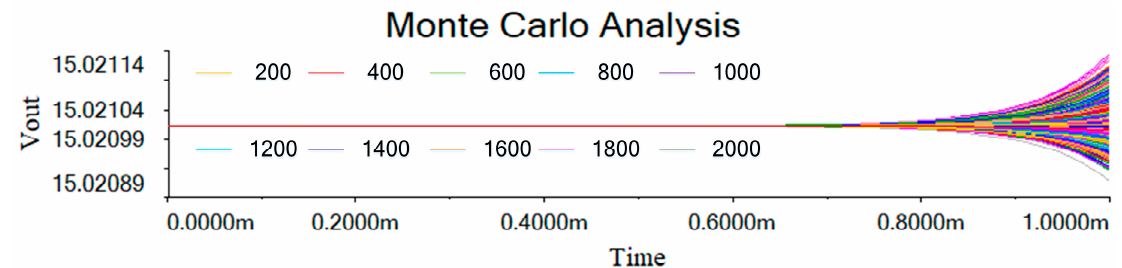
Figure 16. Diagram of the output of the Monte Carlo circuit analysis, different color lines correspond to different number of